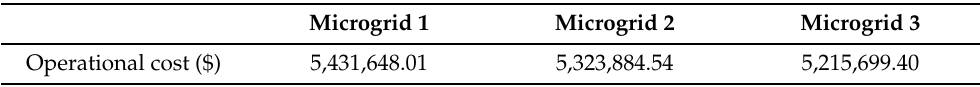
Table 10. Operational costs of